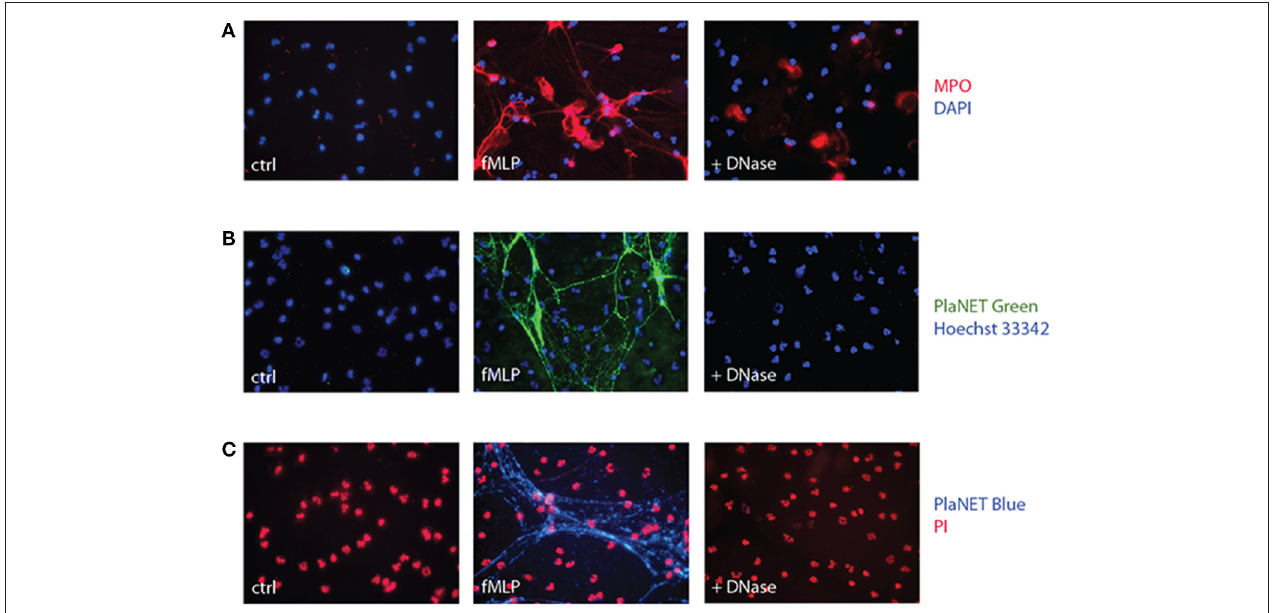
FIGURE 2 | Detection of NETs using MPO or PlaNET reagents in human neutrophils. (A) Neutrophils cultured on poly-L-lysine-coated coverslips were incubated for 4h in the absence (“ctrl”) or presence of 30nM fMLP, and digested or not with DNase I, prior to fluorescent microscopy detection of MPO as described in Methods . A representative experiment is shown (40X magnification). (B) Neutrophils cultured on poly-L-lysine-coated coverslips were incubated for 4h in the absence (“ctrl”) or presence of 30nM fMLP, and further incubated in the presence or absence of DNase I (100 U/ml, 30min, 37 ◦ C), prior to fluorescent microscopy detection of NETs using PlaNET Green and Hoechst 33342 counterstaining, as described in Methods . A representative experiment is shown (40X magnification). (C) Neutrophils were treated as described in (B) ; fluorescent microscopy detection of NETs was conducted using PlaNET Blue and propidium iodide counterstaining (5 µ M, 20min), as described in Methods . A representative experiment is shown (40X